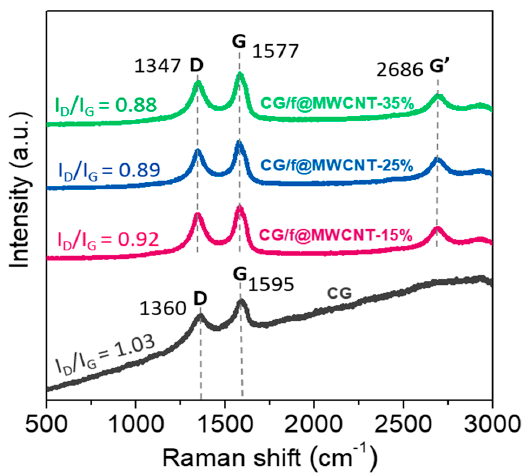
Figure 5. Raman spectra of CG and CG/f@MWCNT composites with different f@MWCNTs contents: 15%, 25%, and 35%.